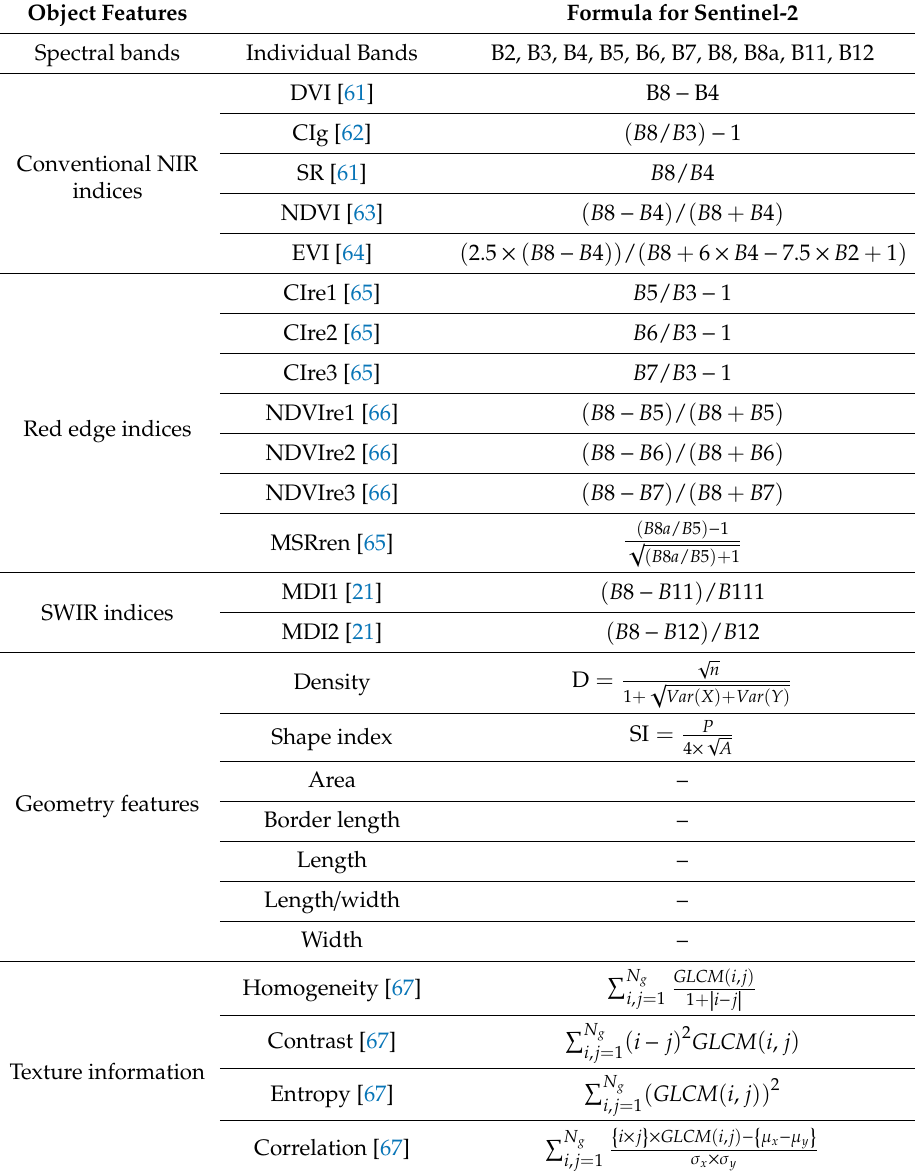
Table 3. A list of features for S. alterniflora